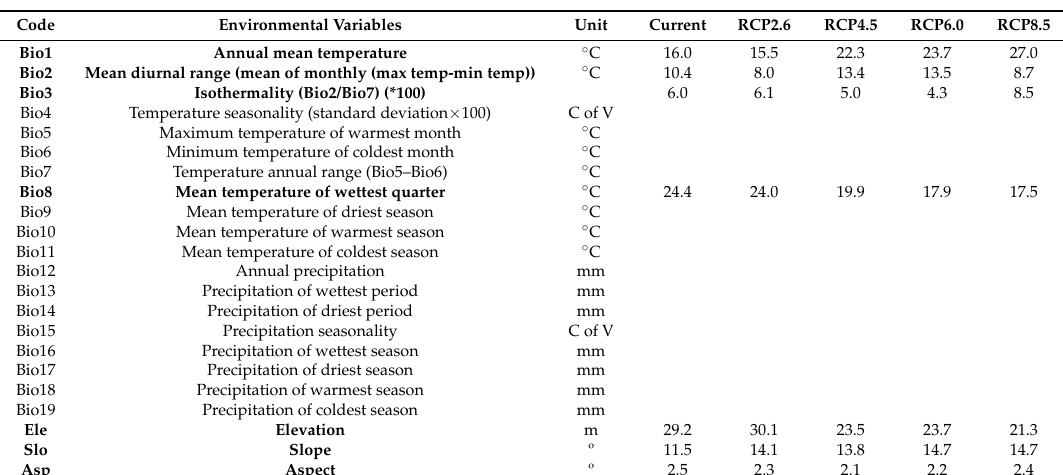
Table 1. 22 Environmental variables downloaded and variables contribution rate (%) to the species distribution under each